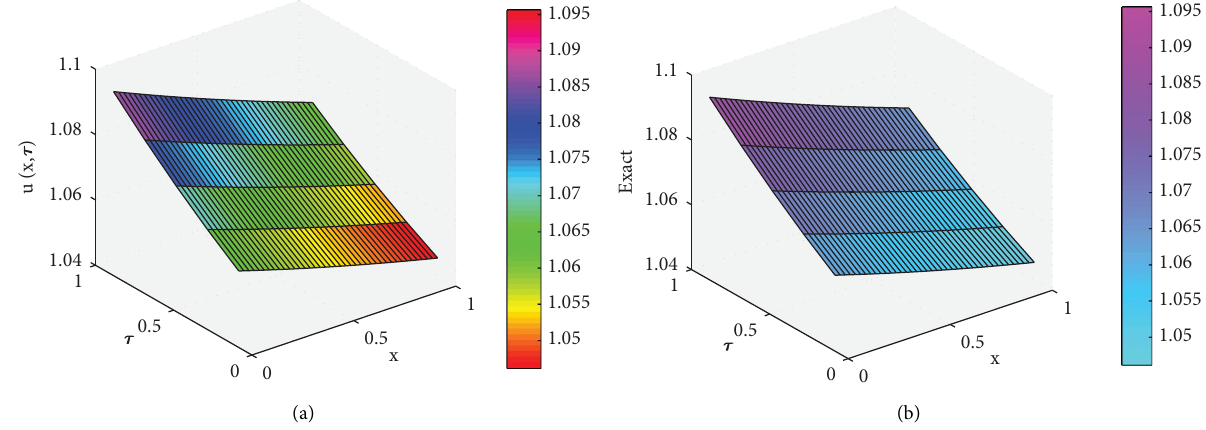
Figure 5: (a) Approximate solution and (b) exact solution of Example 2 at k � 4, M �